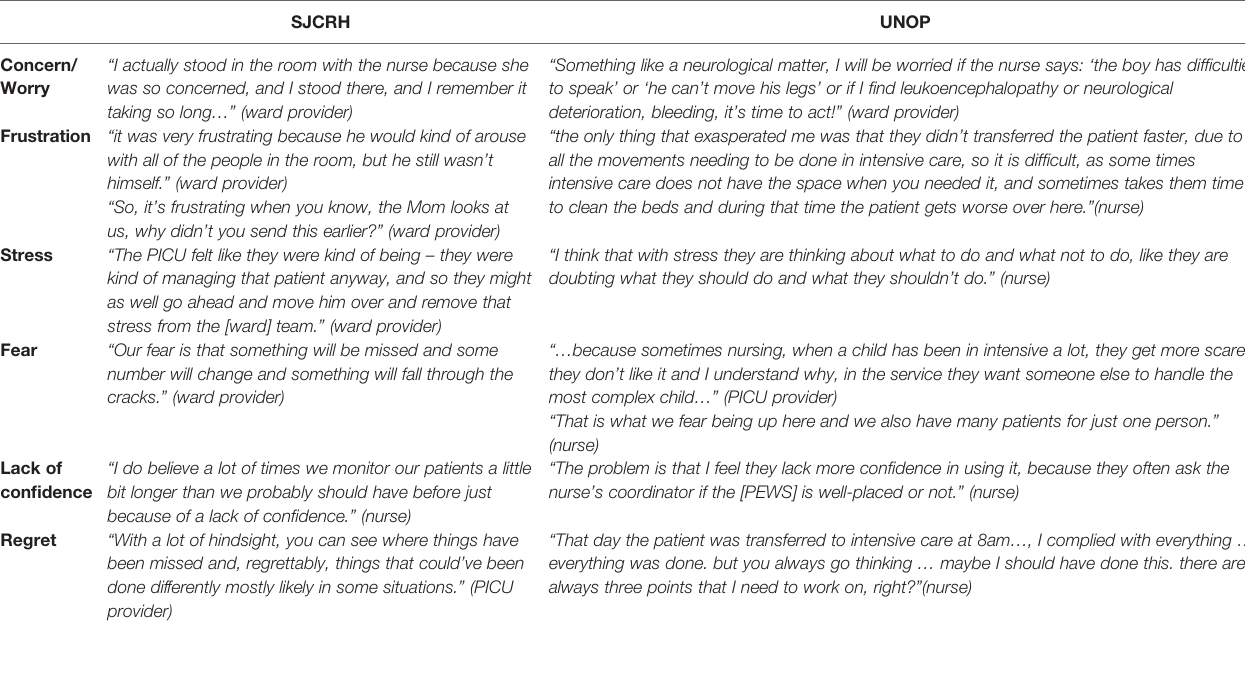
TABLE 2 | Provider emotions around patient